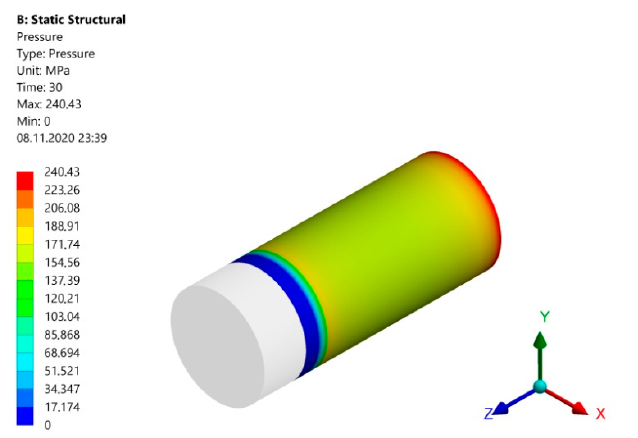
Figure 7. Surface pressures.